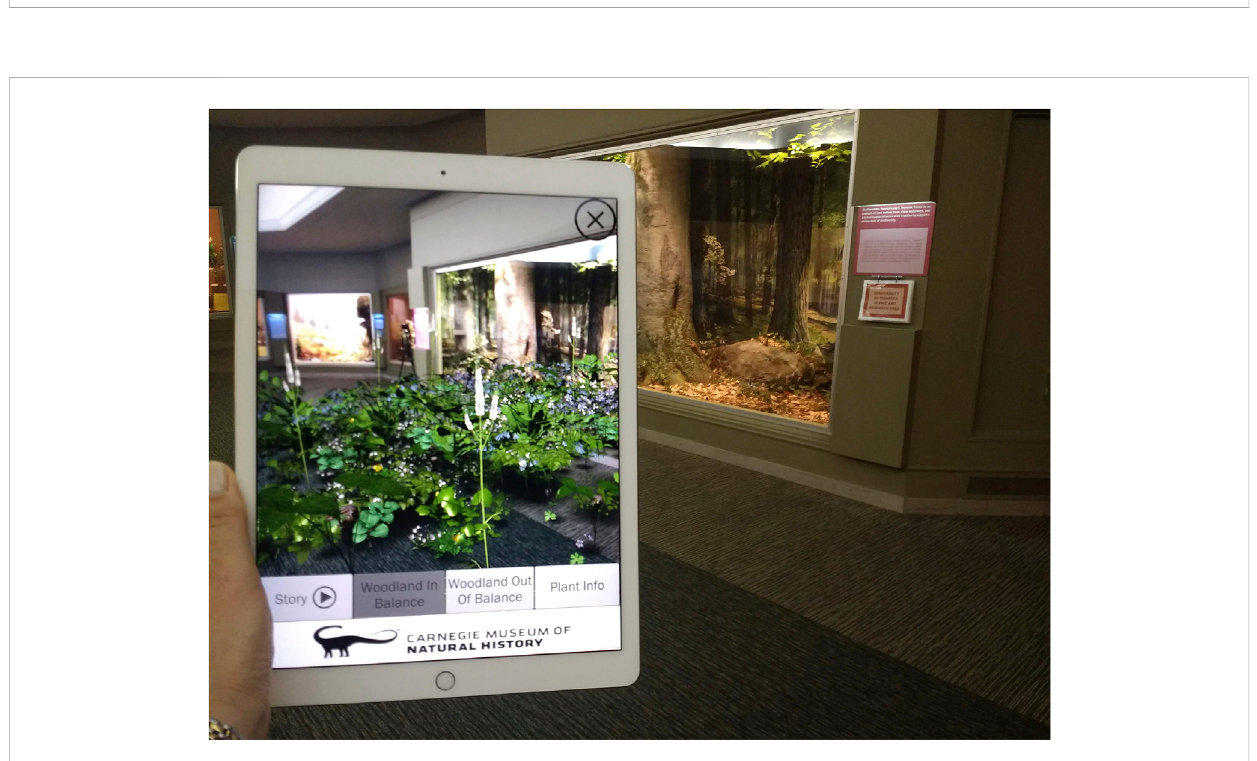
FIGURE 2 AR Perpetual Garden App in use in the Carnegie Museum of Natural History. Harrington, Maria. “ AR Perpetual Garden App. ” Video, 3.21 minutes, September 29, 2018. URL: https://youtu.be/maJ7iOu2BT4